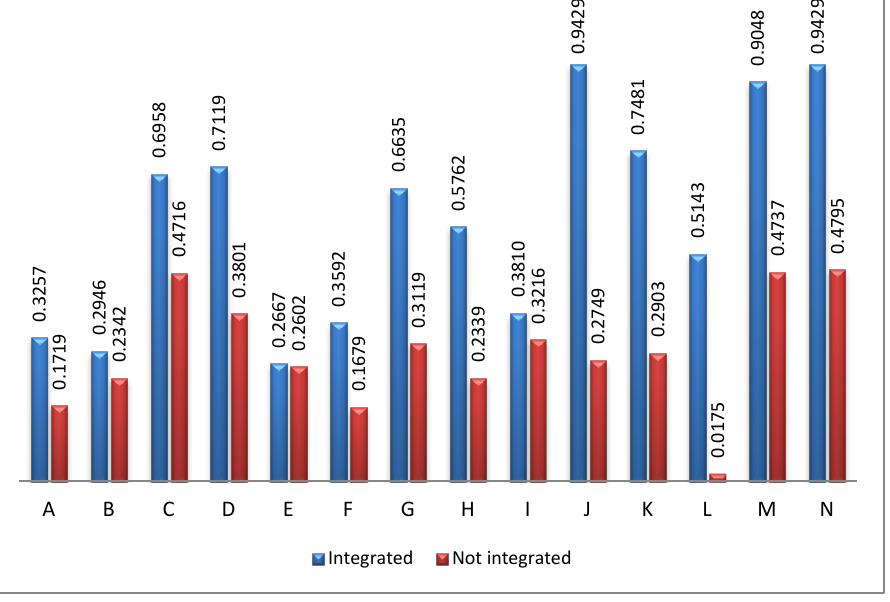
FIGURE 2: Comparison between reports Source: Authors’ analysis